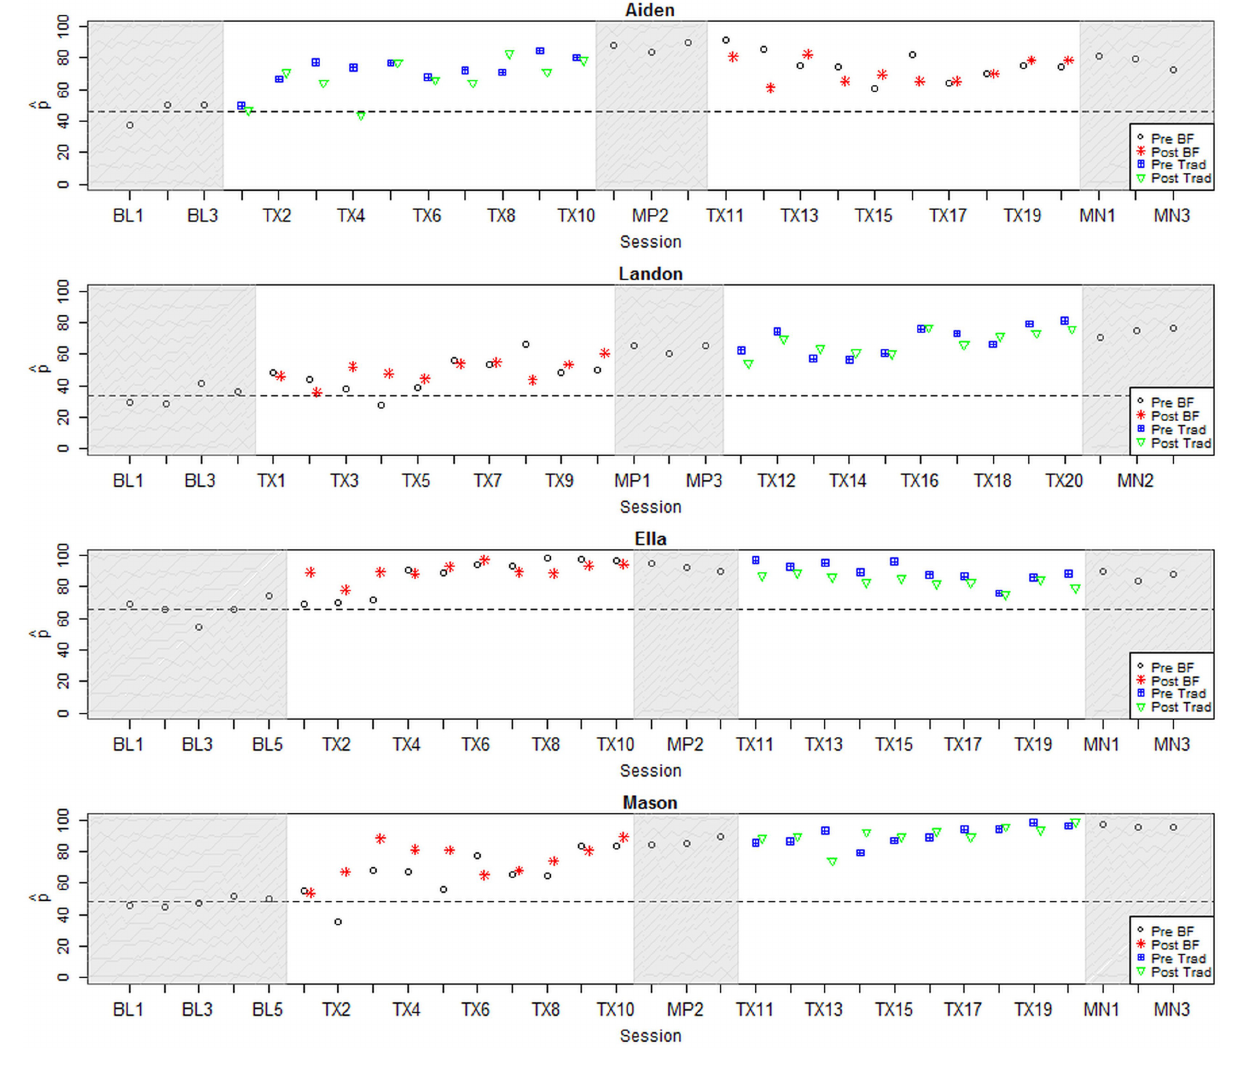
FIGURE 2 | Longitudinal plots of ˆ p correct for participants with large positive effect sizes. Dashed line represents mean across baseline sessions. BL, Baseline; Tx, Treatment; MN, Maintenance; BF, Biofeedback; Trad,